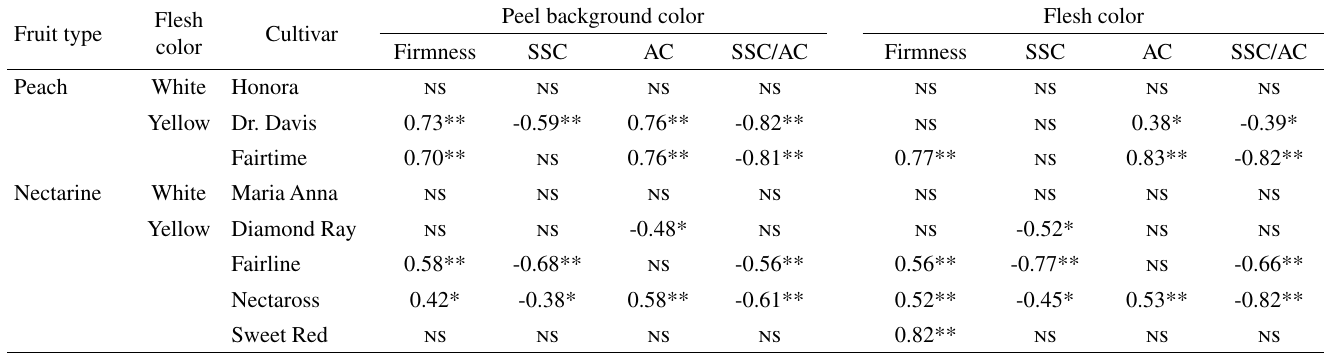
Table 3 - Correlations among peel background color or flesh color and different quality parameters in yellow or white-fleshed peaches and nectarines Fruit type